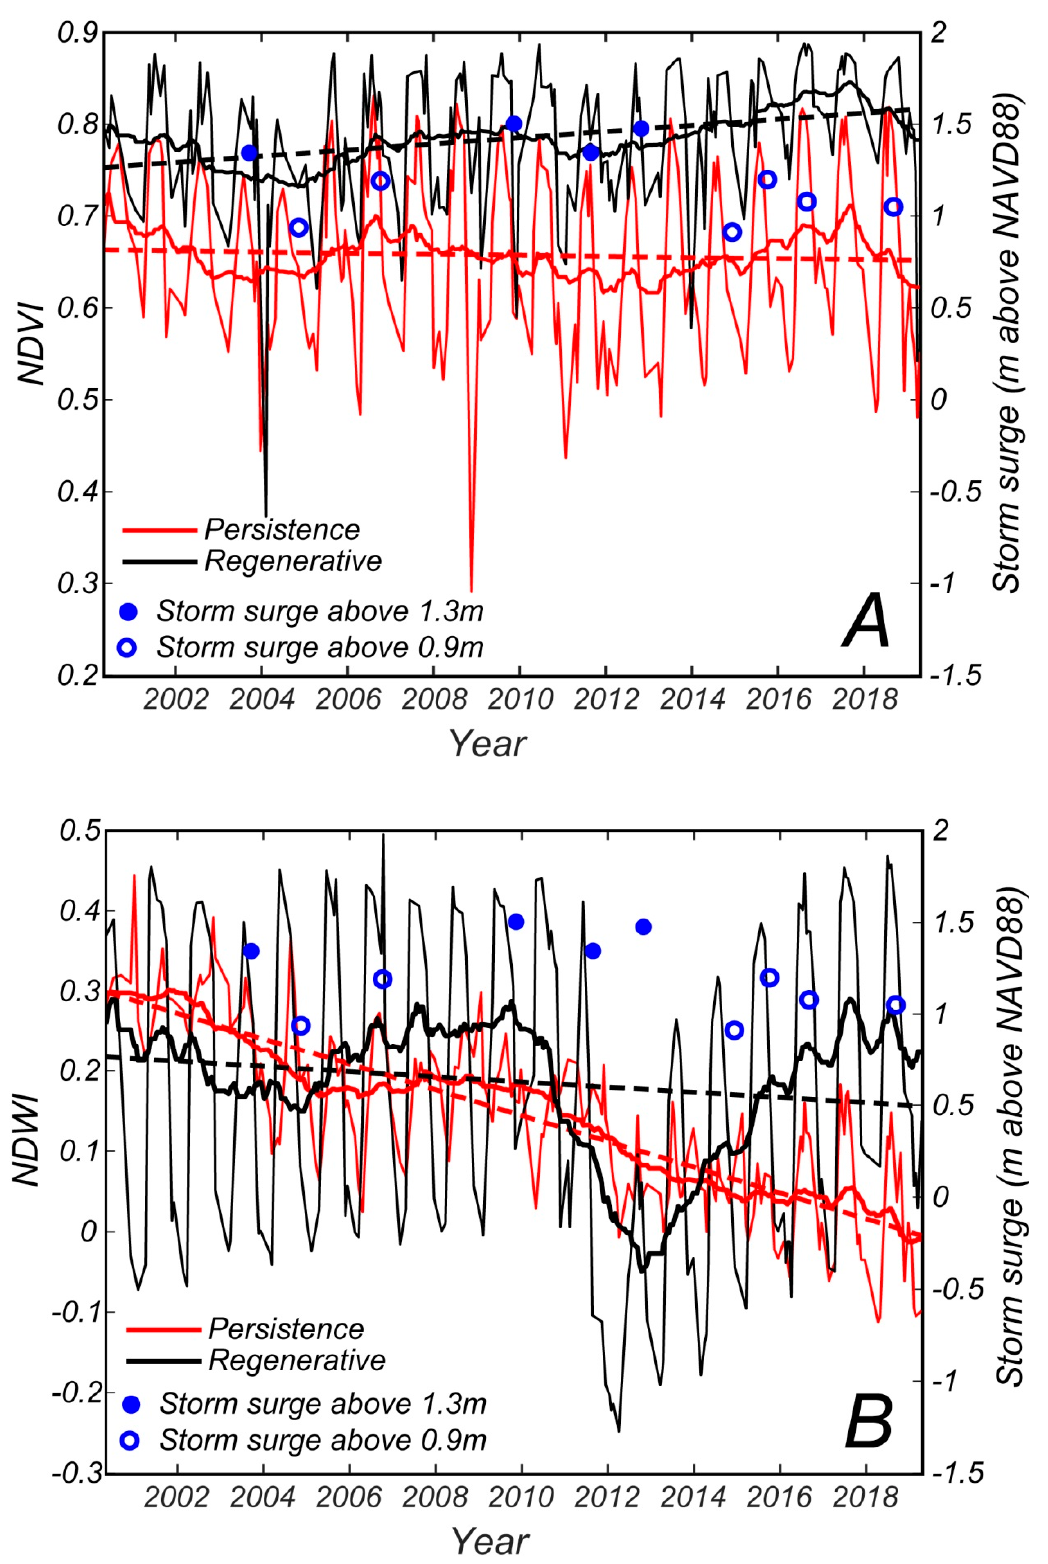
Figure 7. ( A ) Average NDVI values for persistence zone (below 0.92 m) and regenerative zone (above 1.37 m) for all images. ( B ) Average NDWI values for persistence zone (below 0.92 m) and regenerative zone (above 1.37 m) for all images. The thick lines are moving averages of 50 Landsat images. The dotted lines are linear interpolations. The highest storm surges during this period are also indicated as blue dots (maximum storm-surge elevation reported on the right y-axis).